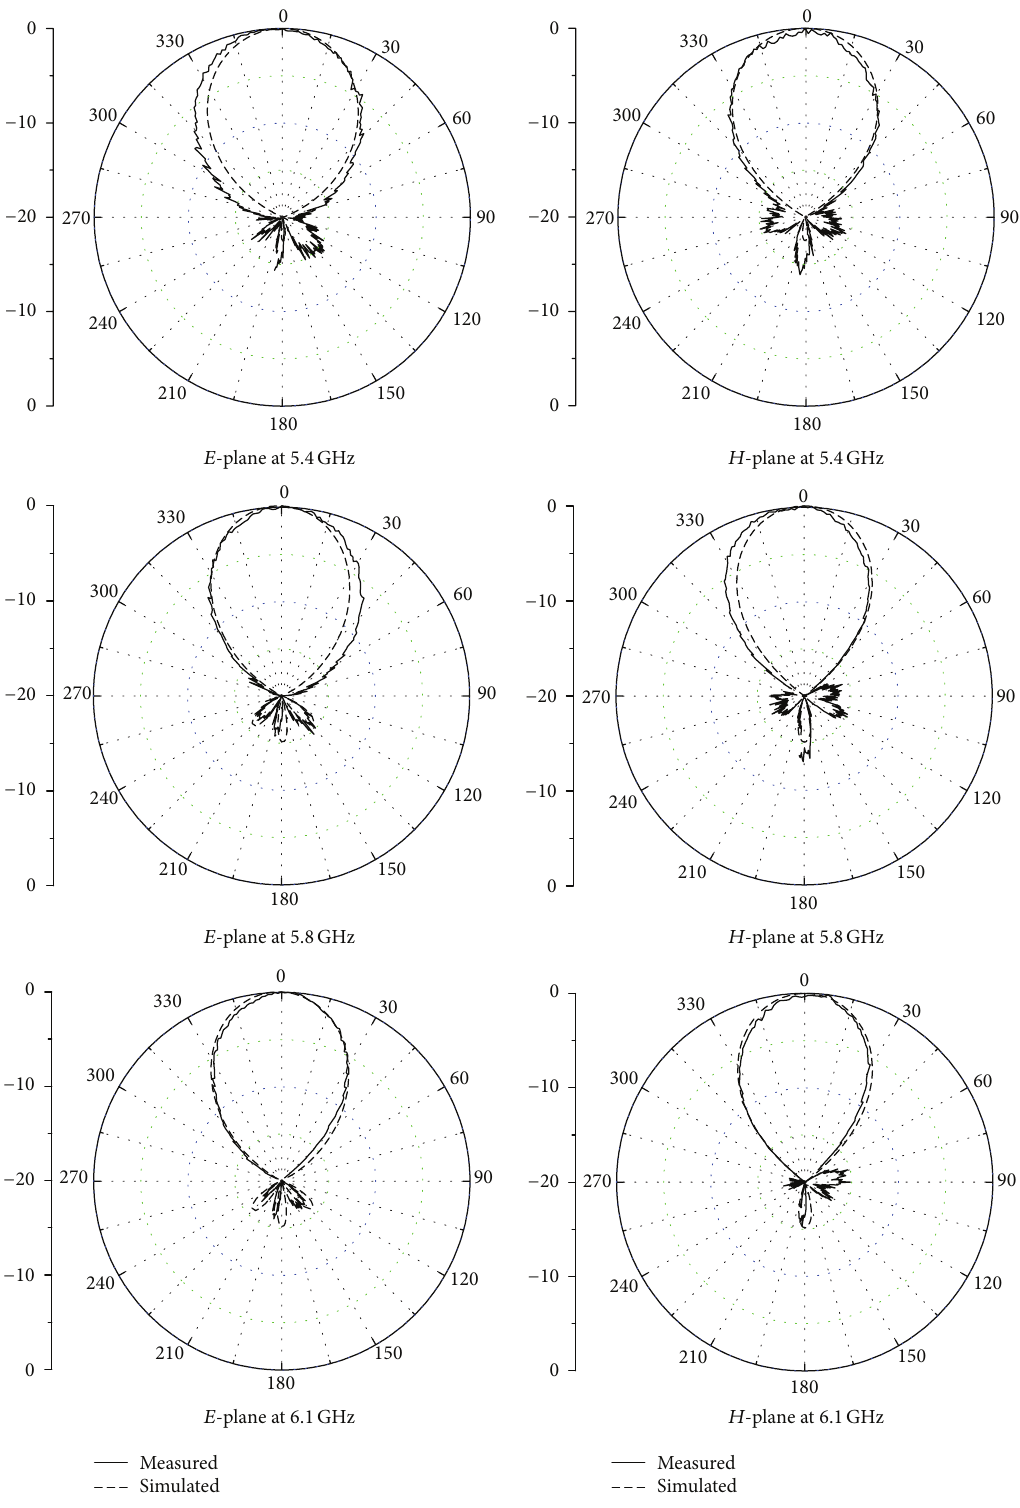
Figure 15: Measured and simulated radiation patterns on the 𝐸 -plane and the 𝐻 -plane at different frequencies of the 2 × 2 fractal antenna